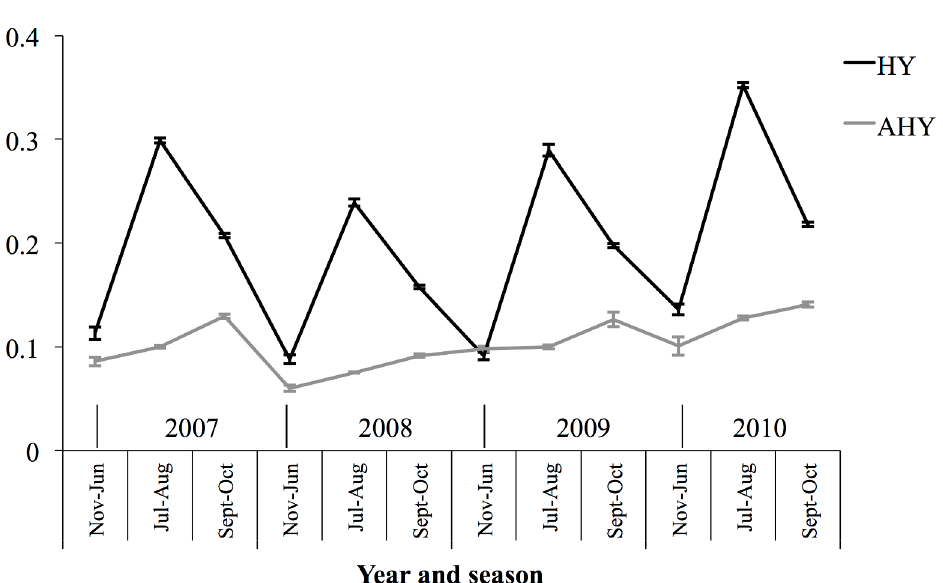
Fig 2. Annual and seasonal means of predicted probability of avian influenza virus infection in Blue-winged Teal in Canada and the US from 2007 – 2010. Point predictions were based on the best-supported model (Table 3) and were averaged across both sexes, and all flyways and latitudes of data. Confidence intervals are calculated based on the variance around the group-mean within each year-season-age category. Hatch year (HY) and after hatch year (AHY) age groups shown separately.